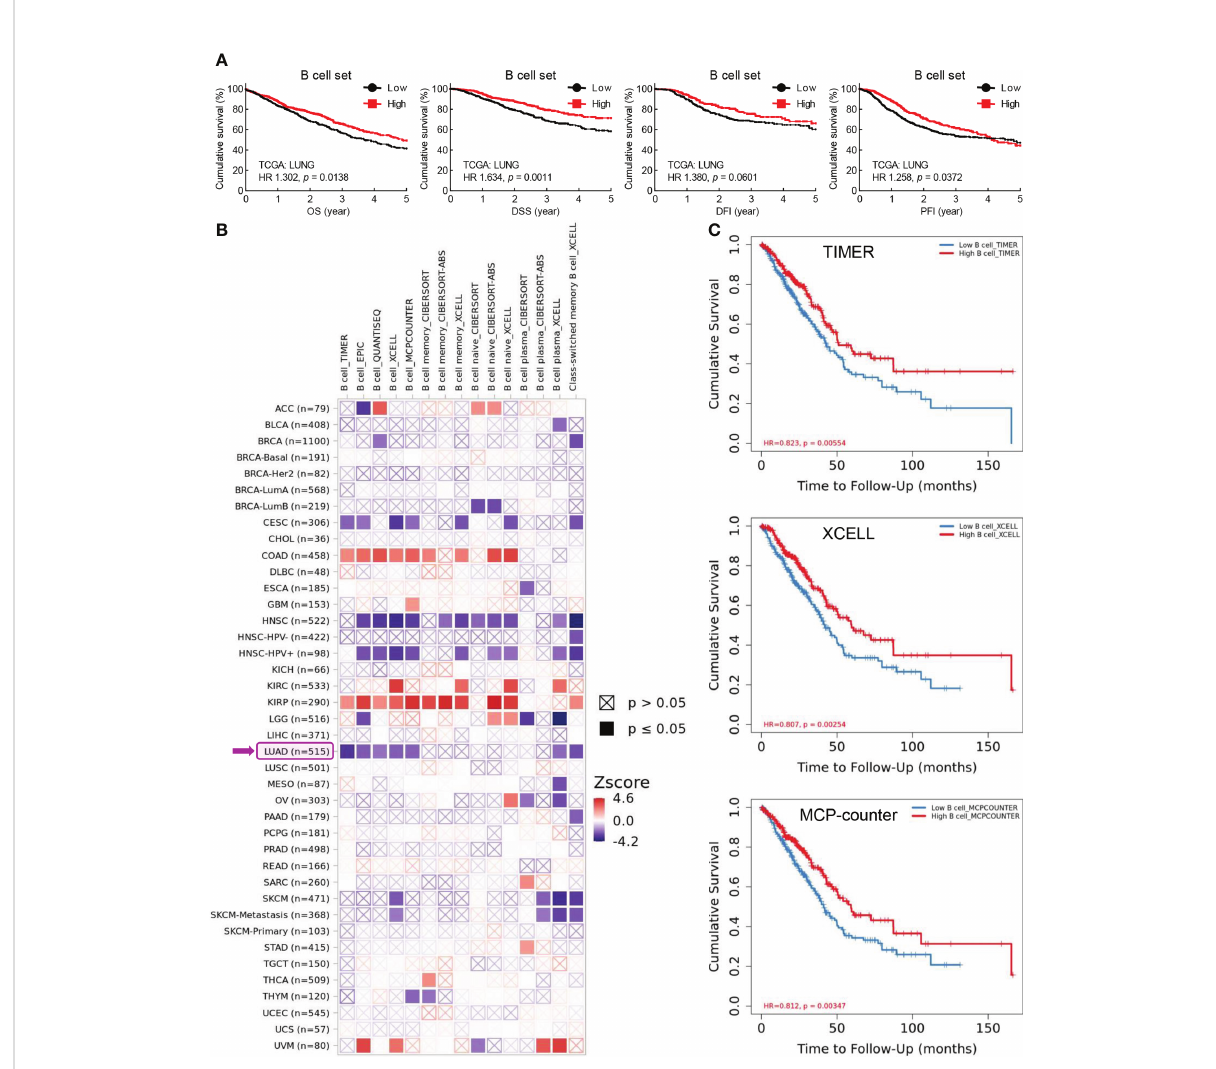
FIGURE 1 Tumor-in fi ltrating B cells are positively associated with patient survival in lung cancer. (A) TCGA LUNG data showing positive correlation between B cell frequency in lung tumor and overall survival (OS), disease speci fi c survival (DSS), disease free interval (DFI), and progression free interval (PFI). B cell set comprises fi ve speci fi c B cell markers (CD19, CD79A, CD79B, BLK, and CD20). (B) TIMER data showing association between B cell in fi ltrates and clinical outcome in human cancers. Z-score > 0: increased risk, Z-score < 0: decreased risk. (C) Kaplan-Meier curves displaying positive association of B cell in fi ltrates with patient survival in lung adenocarcinoma (LUAD) by TIMER, XCELL, and MCP- counter algorithms. The in fi ltration level is equally divided into low and high levels. The hazard ratio (HR) and the log-rank p value for Kaplan- Meier curve were shown in plots (A , C)